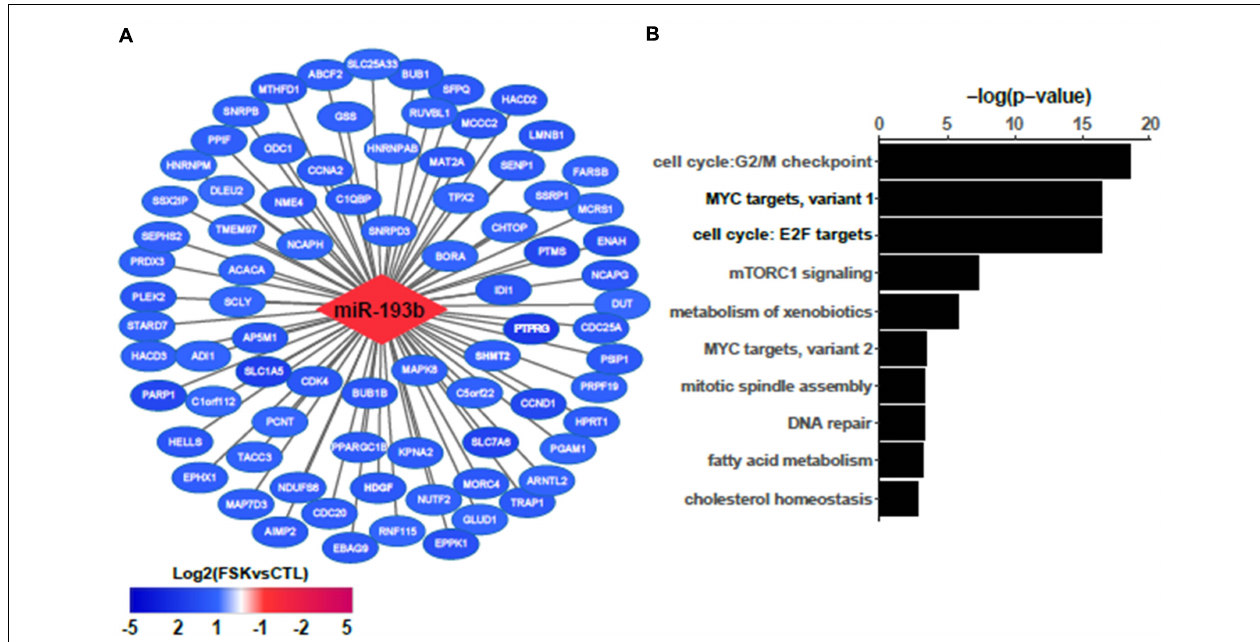
FIGURE 4 | Network analysis identifies miR193b as a hub regulator (A) Most significantly down-regulated genes in BeWo-FSK targeted by miR193b. (B) Hallmarks enrichment analysis of the targets of miR193b deregulated in the BeWo-FSK relative to the BeWo-CO.